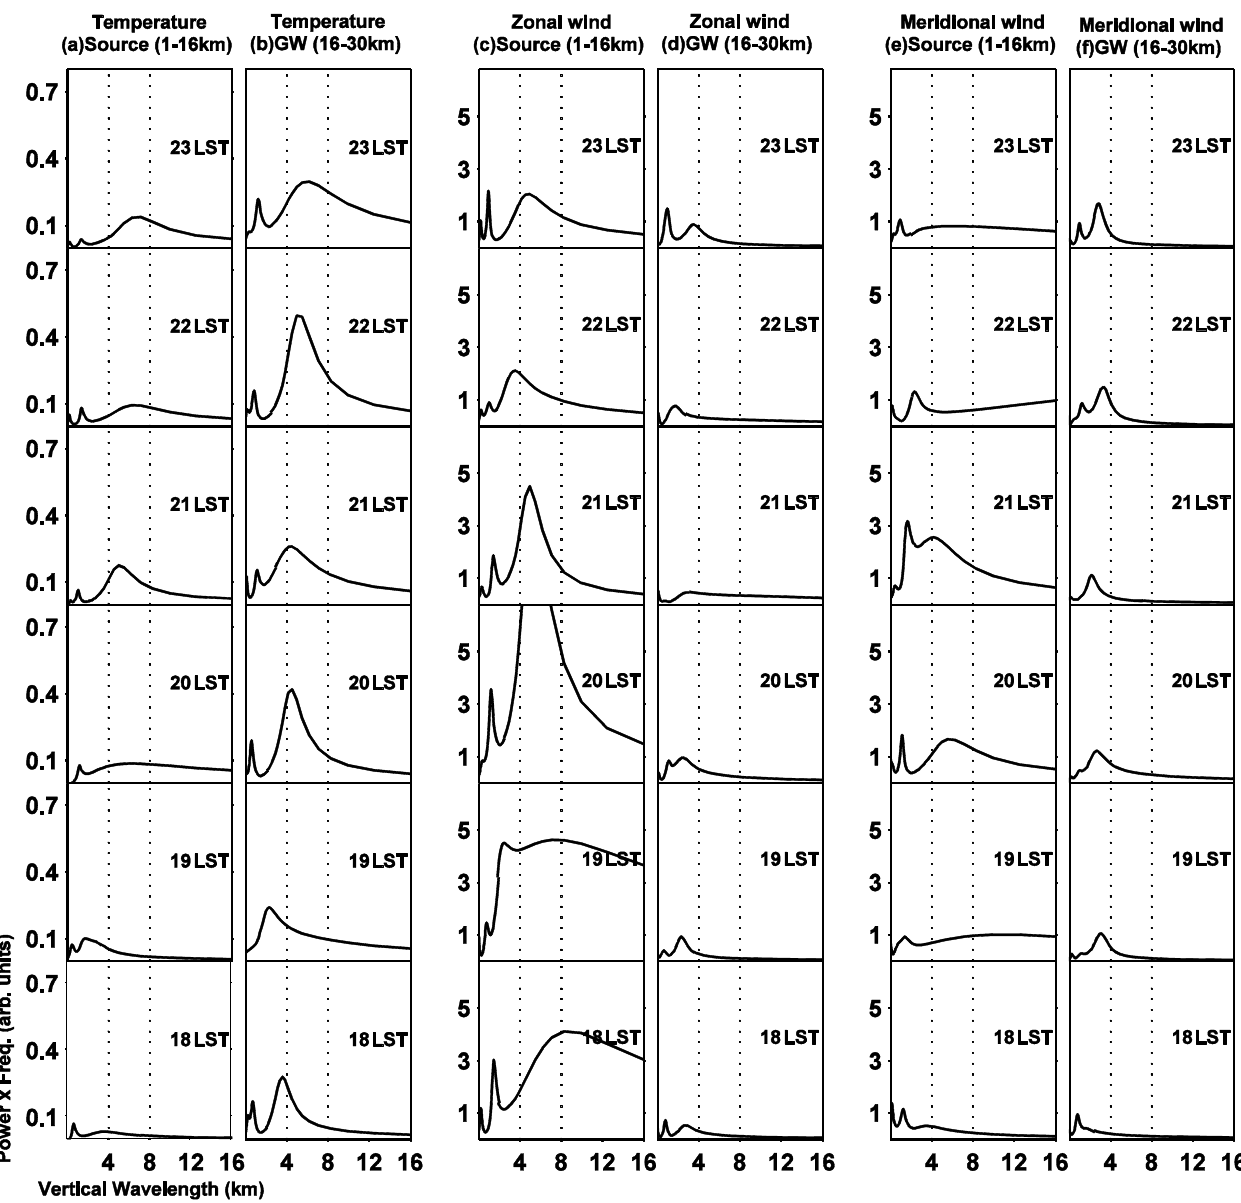
Fig. 11. Same as that for Fig. 10 but for 9 December Figure 11. Same as that for Figure 10 but for 09 Dec 05